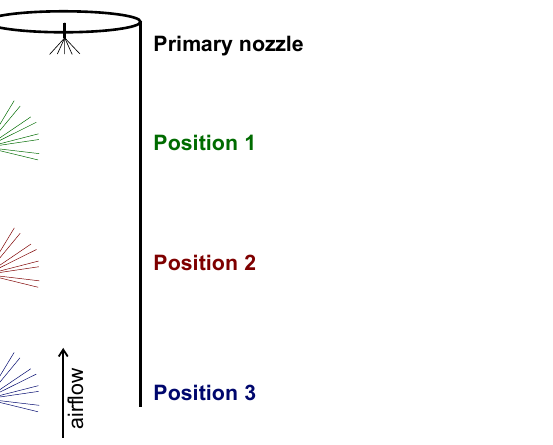
Figure 10. Schematic of lab spray dryer with nozzle locations; primary nozzle at the top and the secondary nozzles (positions 1 to 3, Ref. [9]).